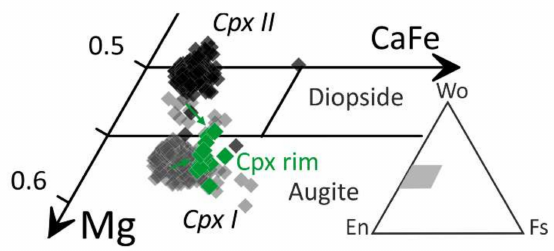
Figure 4. Pyroxene compositions projected onto the pyroxene classification diagram En-Fs-Wo [52]. Green rhombs represent the composition of the clinopyroxene rims; arrows reflect directions of chemical composition change from cores to